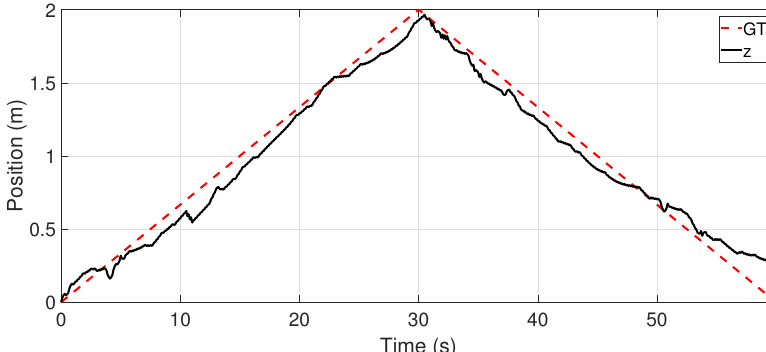
Figure 8. z -axis coordinate tracking for test 1.